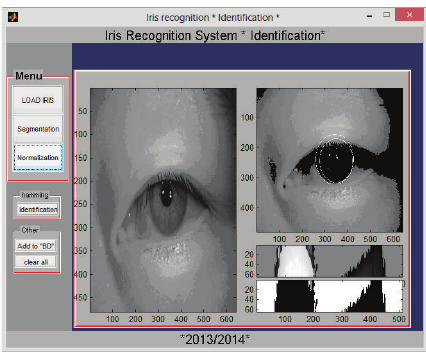
Figure 10: GUI of the identification process in the fingerprint monomodal recognition system.